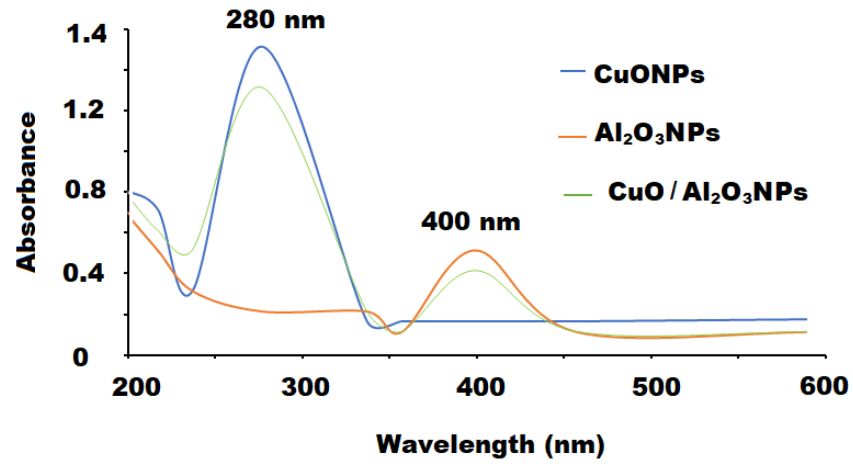
Figure 3. UV-vis spectra of CuONPs ( λ max = 280 nm), Al 2 O 3 NPs ( λ max = 400 nm) and CuO/Al 2 O 3 Figure 3. UV- vis spectra of CuONPs (λ max = 280 nm), Al 2 O 3 NPs (λ max = 400 nm) and CuO/Al 2 O 3 nano- nanocomposite measured at absorption wavelenth ranged between 200–500 nm. composite measured at absorption wavelenth ranged between 200 – 500 nm.